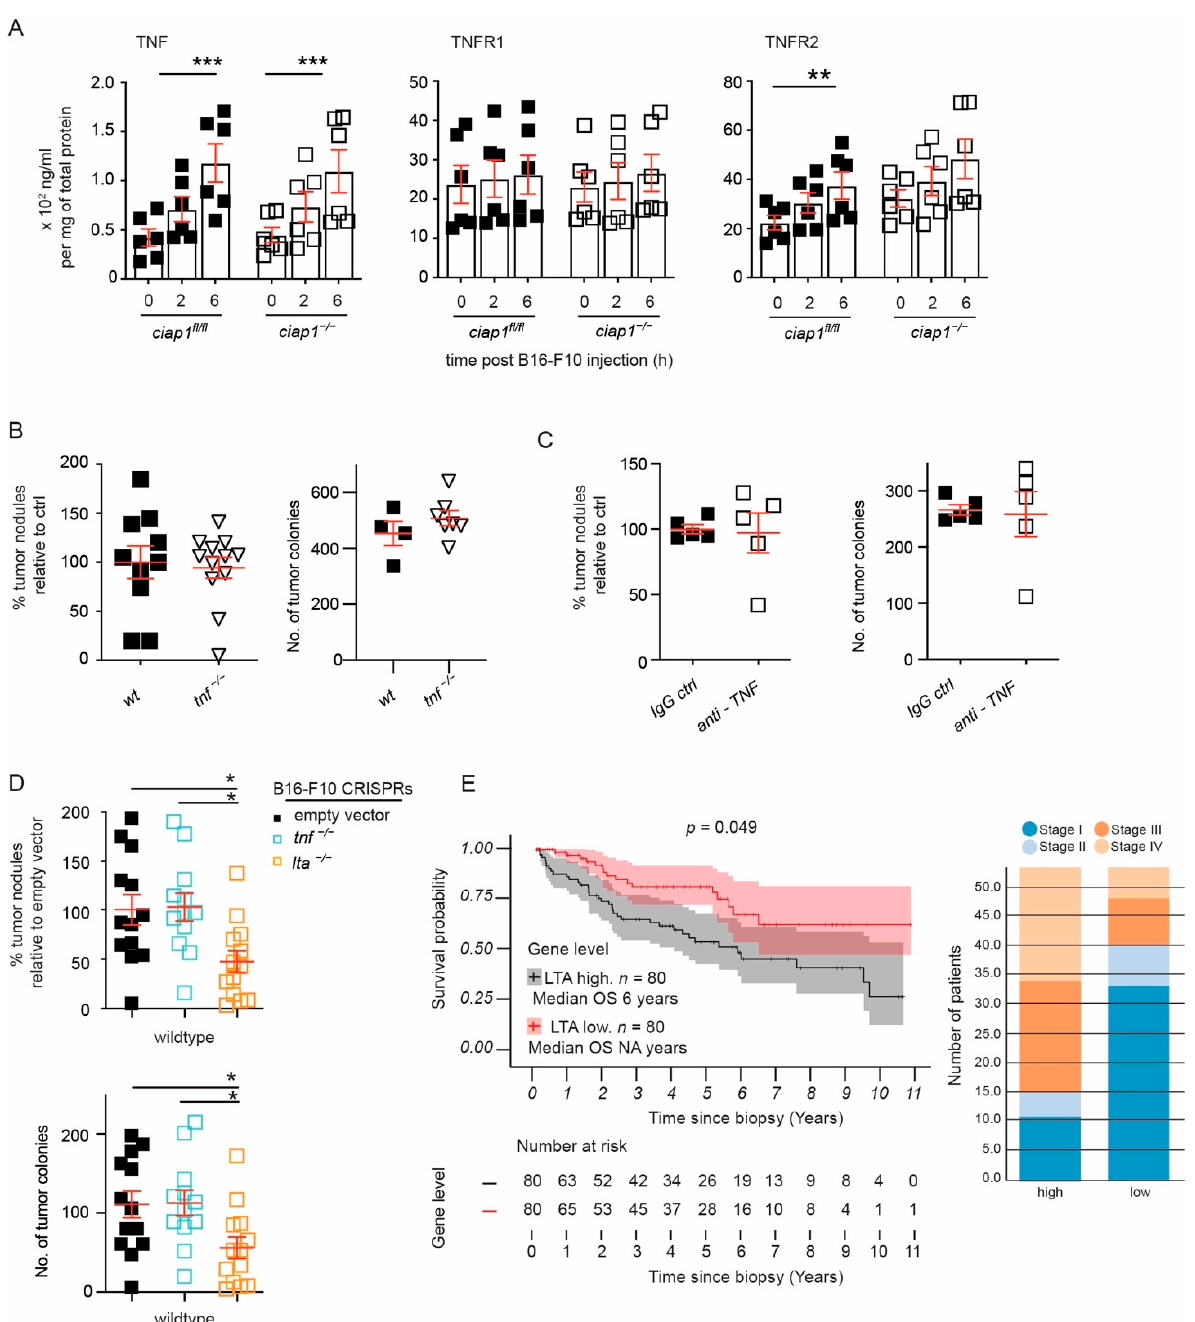
Figure 6. Loss of tumor derived Lymphotoxin A (LTA) reduces lung tumor nodules. ( A ) Levels of TNF and TNFRs assessed using multiplex analysis assay of total lung lysates (6 mice/group performed twice). ( B , C ) Wildtype, TNF deficient mice or wildtype mice pre-treated with anti-TNF (clone MP6-XT22) were injected with B16-F10 cells and tumor nodules in the lung were counted 12–13 days later. Percentage of superficial B16-F10 tumor nodules normalized to the average count of tumor nodules counted in the wildtype mice for an individual experiment. Primary tumor nodule counts are plotted for comparison. ( D ) LentiCRISPR-engineered B16-F10 cells against tnf , lta and control (empty vector) were injected i.v. into wildtype mice and nodules formed in the lung were counted 12 days later. Percentage of superficial B16-F10 tumor nodules normalized to the average number of tumor nodules identified in mice injected with B16-F10 control (empty vector). Primary tumor nodule counts are plotted for comparison. ( E ) Survival curve of high (>85th percentile) versus low (<15th percentile) LTA mRNA expression in kidney renal clear cell carcinoma from TCGA data and distribution of high versus low expression of LTA by disease stage. Data are presented as mean ± SEM. * p < 0.05; ** p < 0.01; *** p < 0.001. Two-way ANOVA with multiple comparison ( A ), two-tailed unpaired t-test ( B , C ), One way ANOVA with multiple comparison ( D